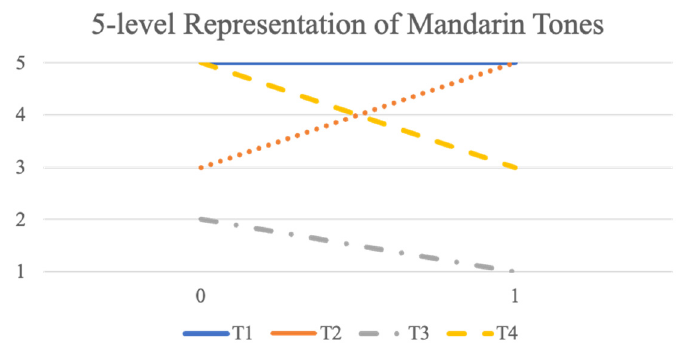
Figure 4. Five-level Representation of Mandarin Tones.